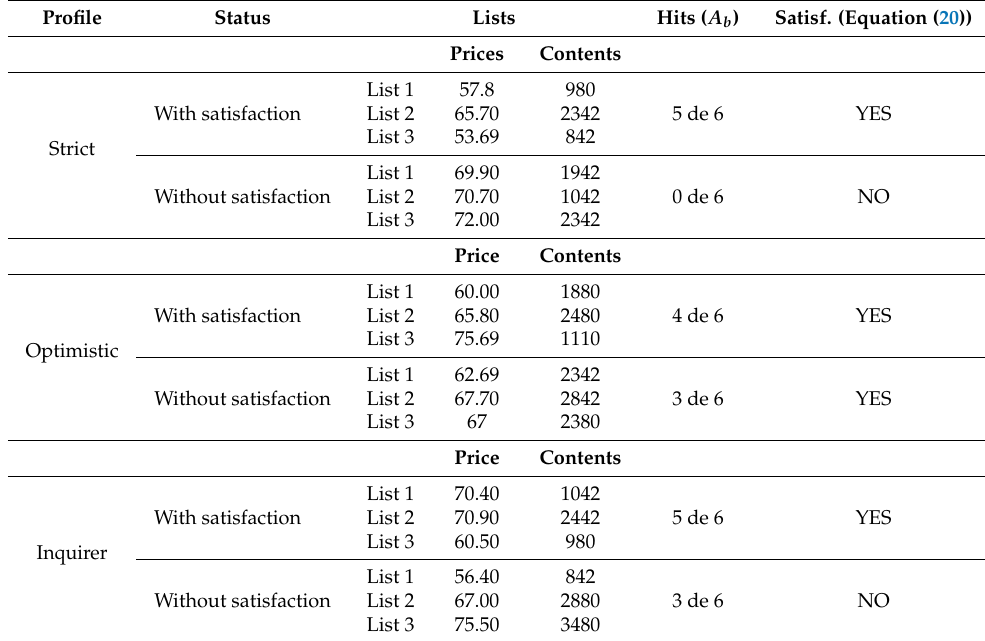
Table 24. Experimentation of the impact of satisfaction in three individuals with different deci- sion